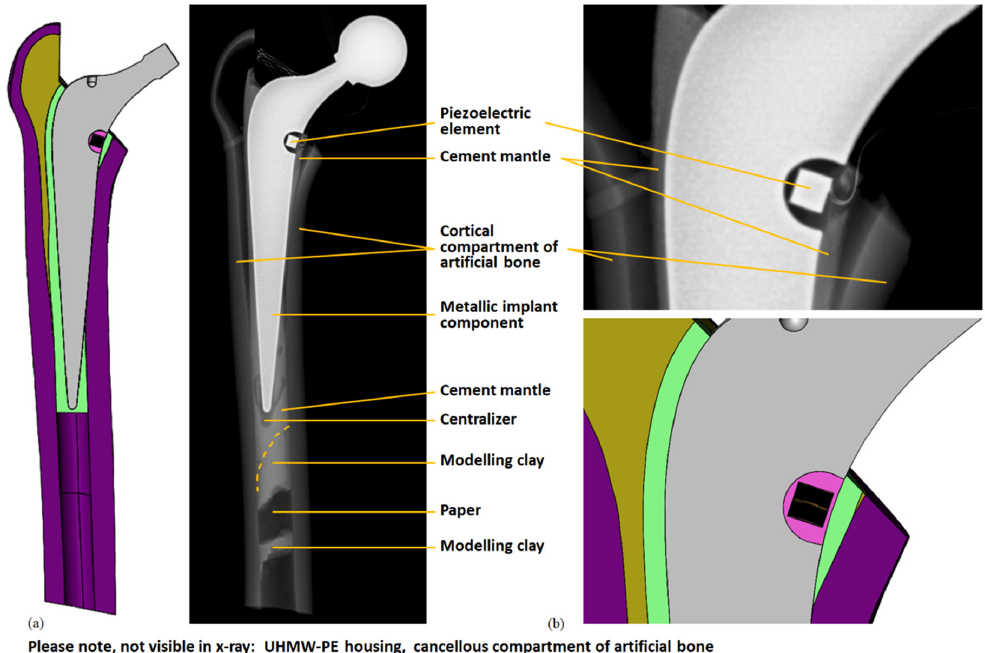
Figure 6. Comparison of virtual and realised implantation. Cross-sectional view of the CAD model (cf. Figure 1) and X-ray image: ( a ) energy harvesting system with artificial bone; ( b ) detail of the energy harvesting system. The cables from the piezoelectric element and strain gauge are also visible. The modelling clay and paper were used to prevent the cement from pouring too far into the medullary cavity and the centraliser assured a central position of the distal implant tip; these parts were not contained in the CAD model.